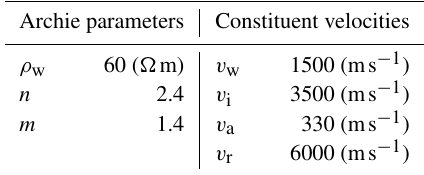
Table A1. Parameters used for the petrophysical joint inversion of the El Jote and El Ternero datasets (Eqs. A2 and A3). Archie